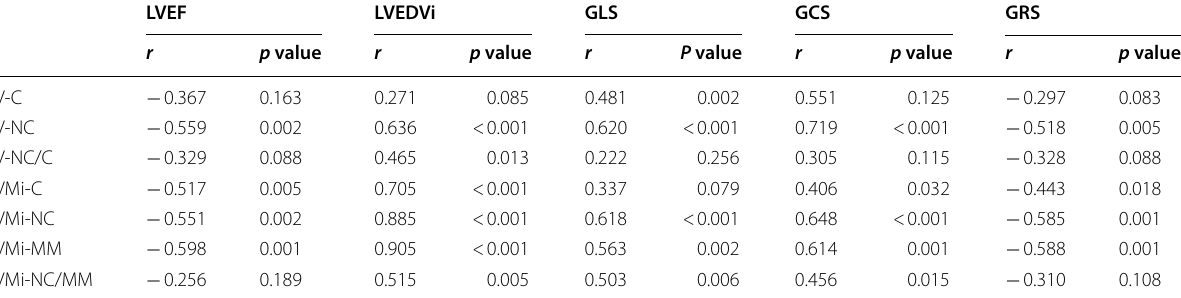
Table 3 Correlations between cardiac magnetic resonance